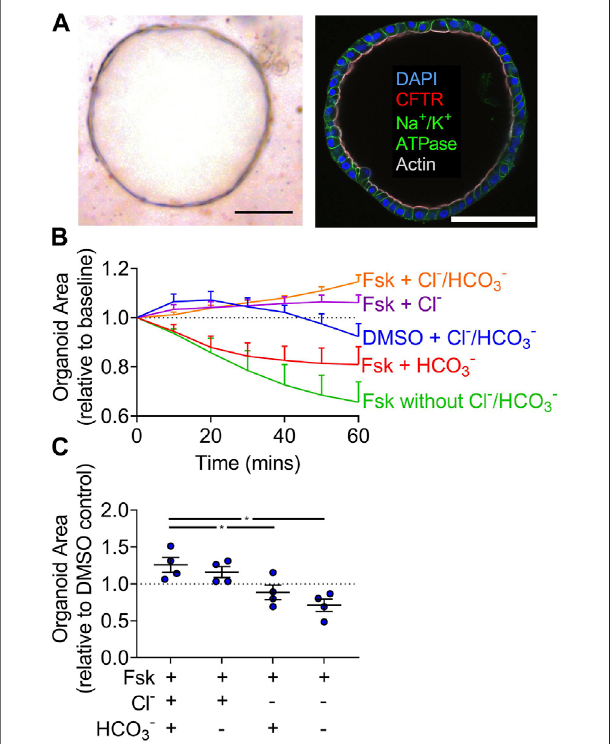
FIGURE 1 | Full cAMP-induced swelling of gallbladder organoids requires Cl − . (A) Bright fi eld image and immuno fl uorescence (scale bar = 100 µm) of a human gallbladder epithelial organoid (scale bar = 100 µm). (B) Organoidareanormalizedtobaselineover1 hinKrebs ’ /HCO 3 − +vehicle and Krebs ’ /HCO 3 − , HCO 3 − -free, Cl − -free, Cl − /HCO 3 − -free + 10 µM forskolin (Fsk). Each line represents the average of four donors. Bars represent SEM. (C) Individual donor values for 1 h time-point normalized to DMSO control for that donor in Krebs ’ /HCO 3 − . Bars indicate mean ± SEM. * indicates p -value < 0.05; one-way ANOVA with Dunnett correction for multiple